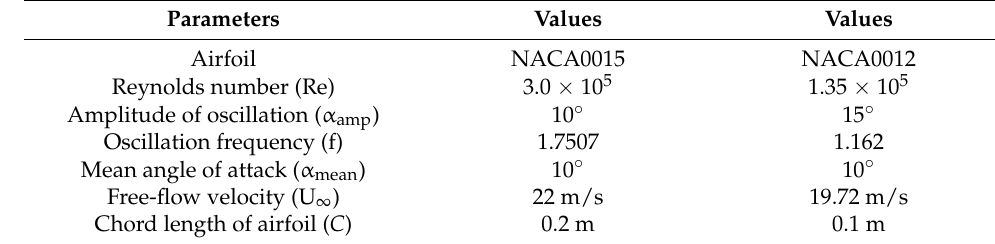
Table 1. Parameters for the computational case. Parameters